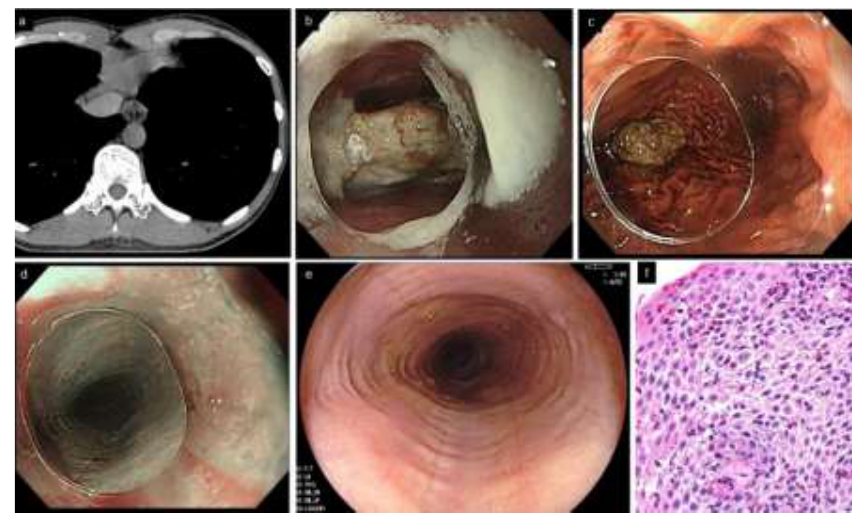
Figure 1. A typical patient with EoE complicated by food impaction (33 years old, male). ( a ). Chest CT. Esophageal lumen is dilated and filled with structures that appear to be impacted food. ( b , c ). Urgent endoscopy. Food bolus (piece of meat) is present in the middle esophagus. Impacted food is removed by letting it drop into the stomach, pushing with an endoscope equipped with a clear distal attachment hood. ( d ). Subtle rings and furrows are visible by narrow band imaging, suspicious of EoE. ( e ). Rings and furrows are more distinctly observed in the re-endoscopy after one week without PPI. ( f ). Esophageal biopsies show a peak of 52 eosinophils/hpf. EoE, eosinophilic esophagitis; PPI, proton pump